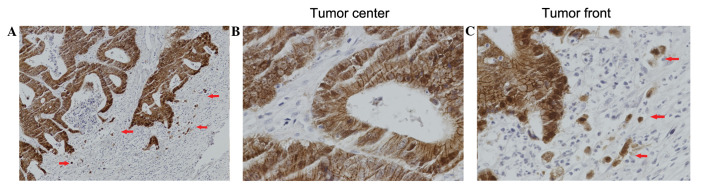
Immunohistochemical staining demonstrating differential β-catenin expression levels at the tumor center and at the tumor invasive front. (A) Overview picture demonstrating both the tumor center and the tumor invasive front. The red arrows indicate tumor budding and nuclear β-catenin expression. (magnification, ×200). (B) At the tumor center, β-catenin expression was predominant at the cell membrane. (C) At the tumor invasive front, the red arrows indicate that the isolated single tumor cells or the small clusters of tumor cells (tumor budding) had scattered from the primary mass with marked nuclear β-catenin accumulation (epithelial-mesenchymal transition phenotype; magnification, ×400).